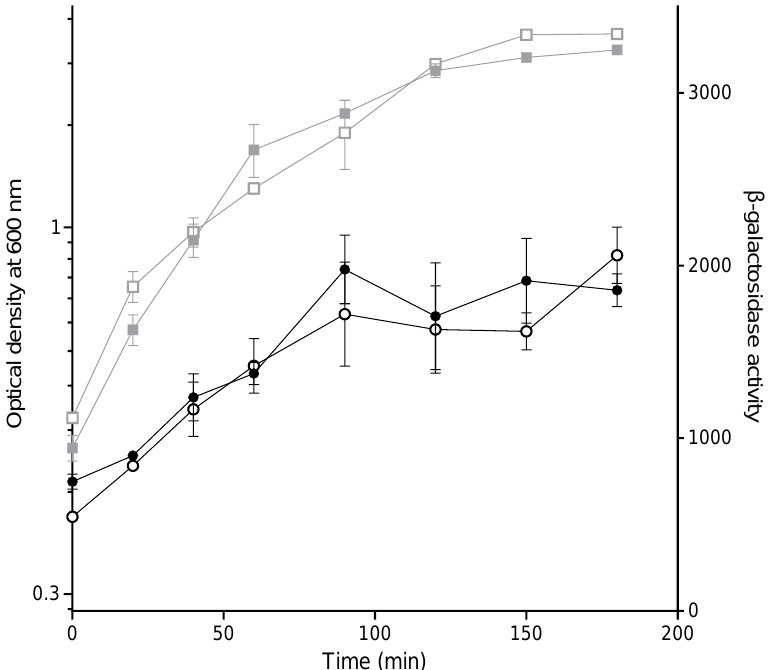
Figure 3. CuSO 4 does not alter expression from the P Y promoter. A P Y - lacZ strain (PAS3) was grown to log phase, after which the culture was split and 3 mM CuSO 4 added (open symbols) or not added (closed symbols). OD600 is shown as gray squares and β -galactosidase activity as black circles. Symbols represent the mean, and the error bars are the standard error of the mean (SEM) of 2 biological replicates.